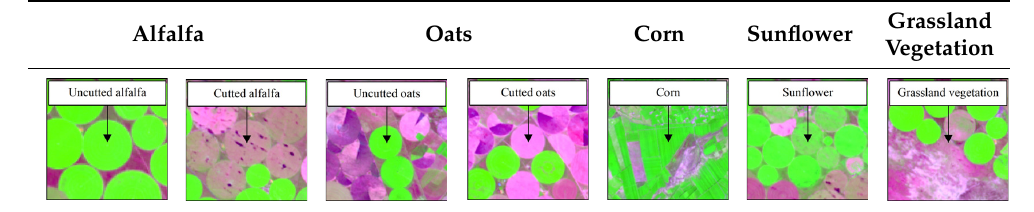
Table 4. Image features of different vegetation types at the peak growth stage (false color synthesis).